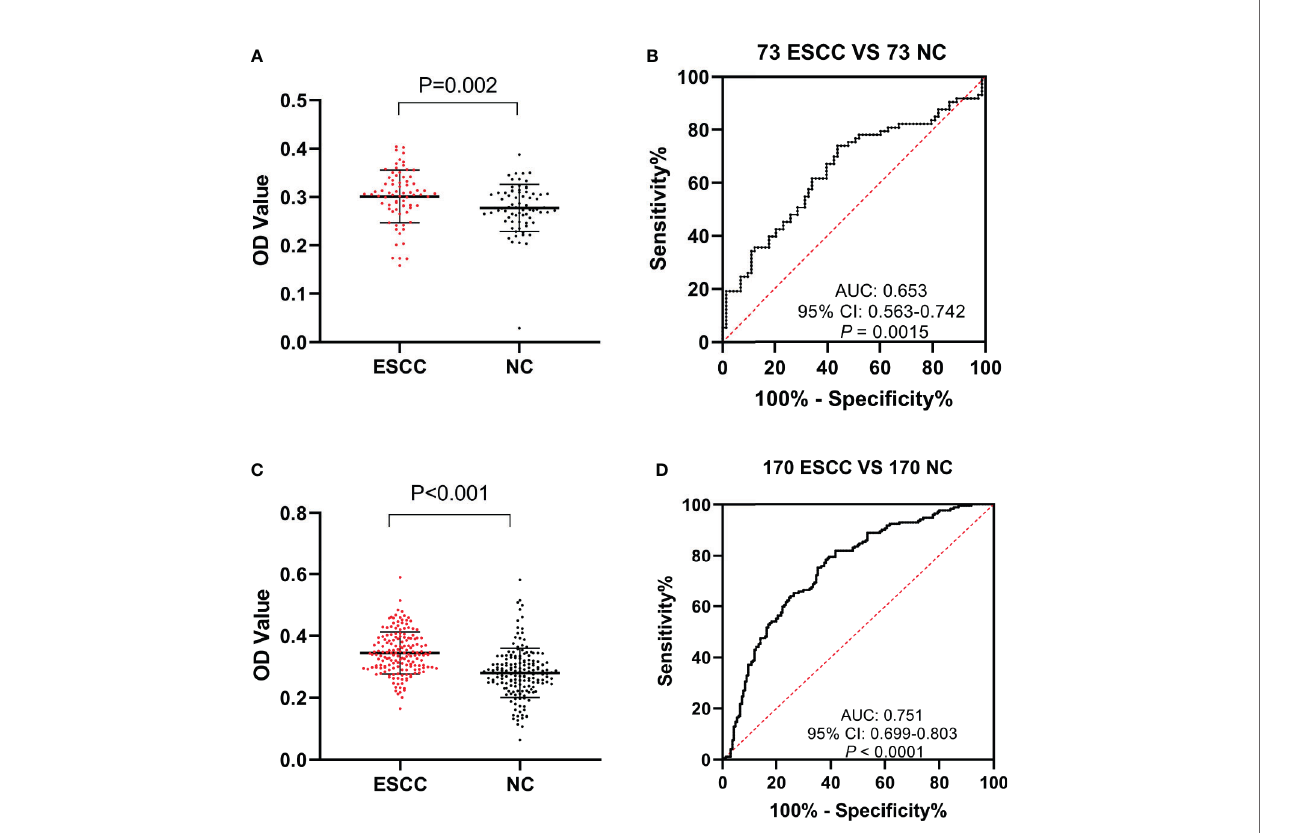
FIGURE 3 | The expression level and diagnostic value of anti-GNA11 autoantibody in the phases of veri fi cation and validation. (A, C) The expression level of anti- GNA11 autoantibody in ESCC patients and normal controls in veri fi cation cohort and validation phase. (B, D) ROC analysis of anti-GNA11 autoantibody in the